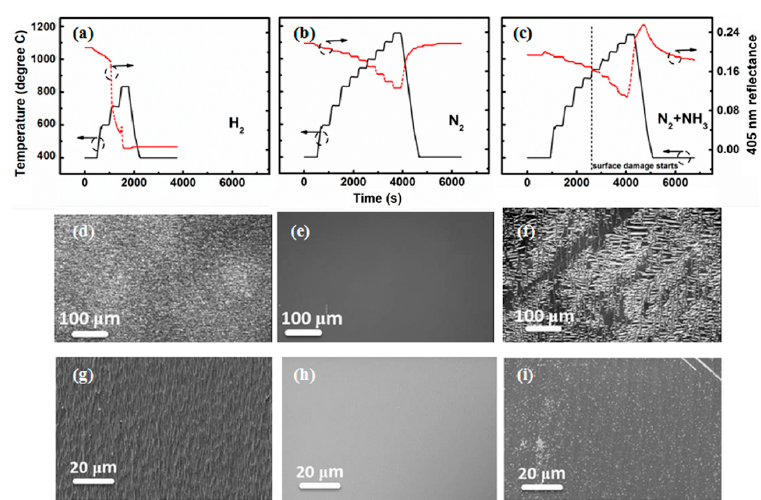
Figure 6. Temperature transients (temperature from EpiTT) and reflectance (405 nm) of ( − 2 0 1) β -Ga 2 O 3 heated under ( a ) H 2 , ( b ) N 2 , and ( c ) N 2 plus NH 3 atmosphere with corresponding optical images of the resulting surfaces in ( d ), ( e ), and ( f ) and SEM images in ( g ), ( h ), and ( i ). Reprinted with permission from reference [108]. Copyright 2017 Elsevier.